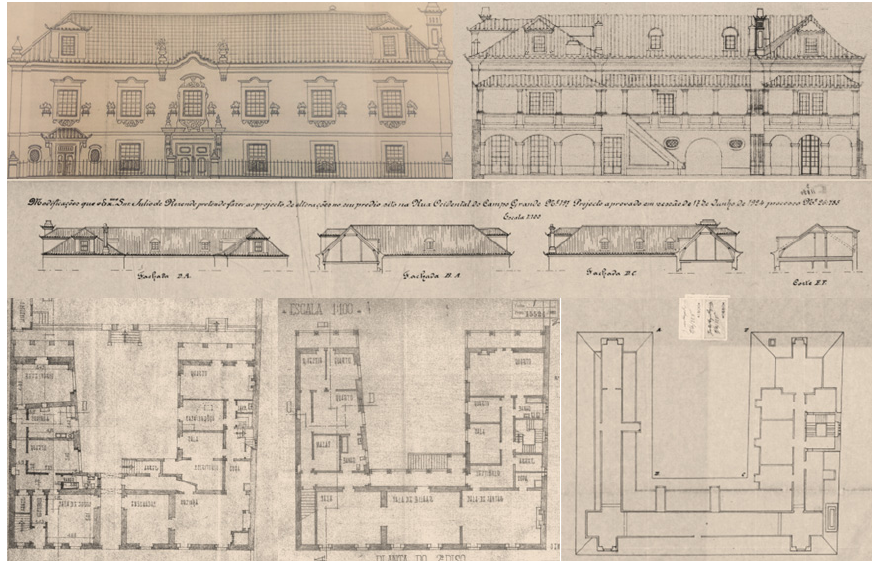
Figure 5. Old drawings of the building.